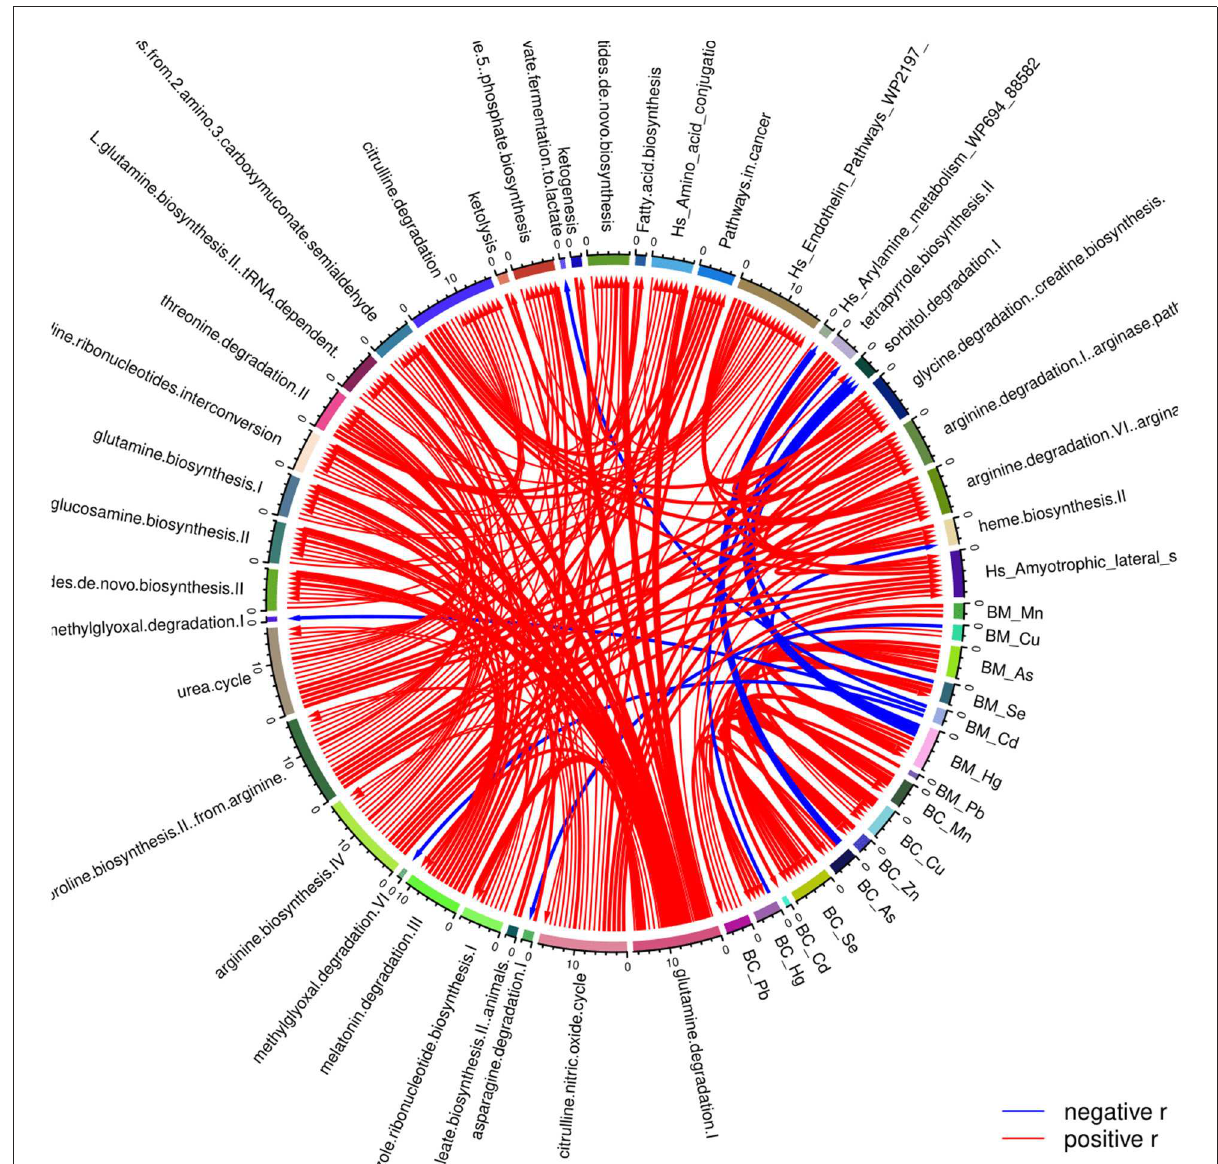
FIGURE4 Correlation globe of the exposure parameters and the pathways resulted from the detected metabolites in the PHIME participants. Prenatal concentration of Hg is negatively associated with the metabolic pathway sorbitol degradation I, while postnatal exposure to As is significantly associated with the metabolism of